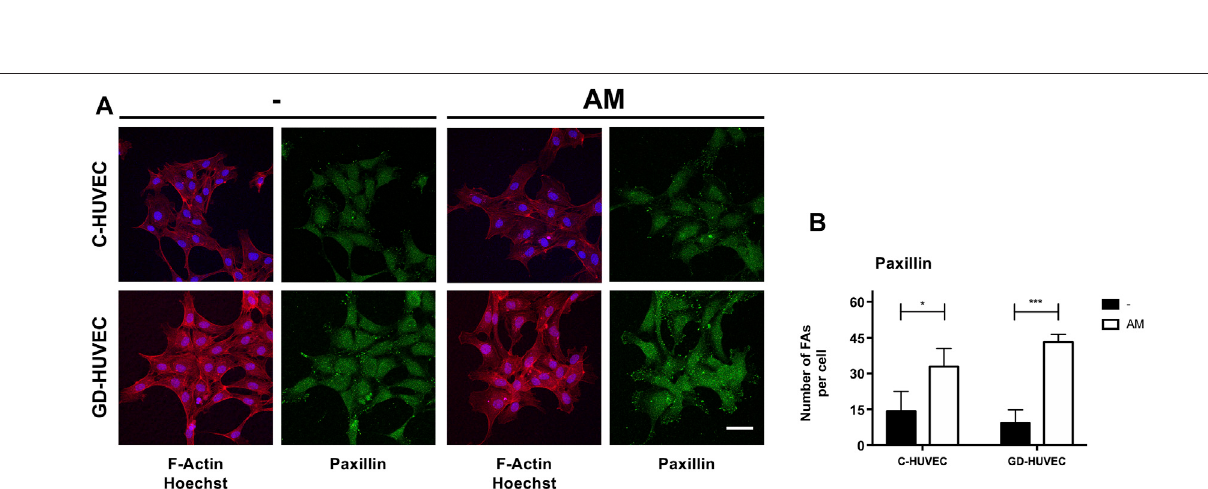
Frontiers in Bioengineering and Biotechnology |